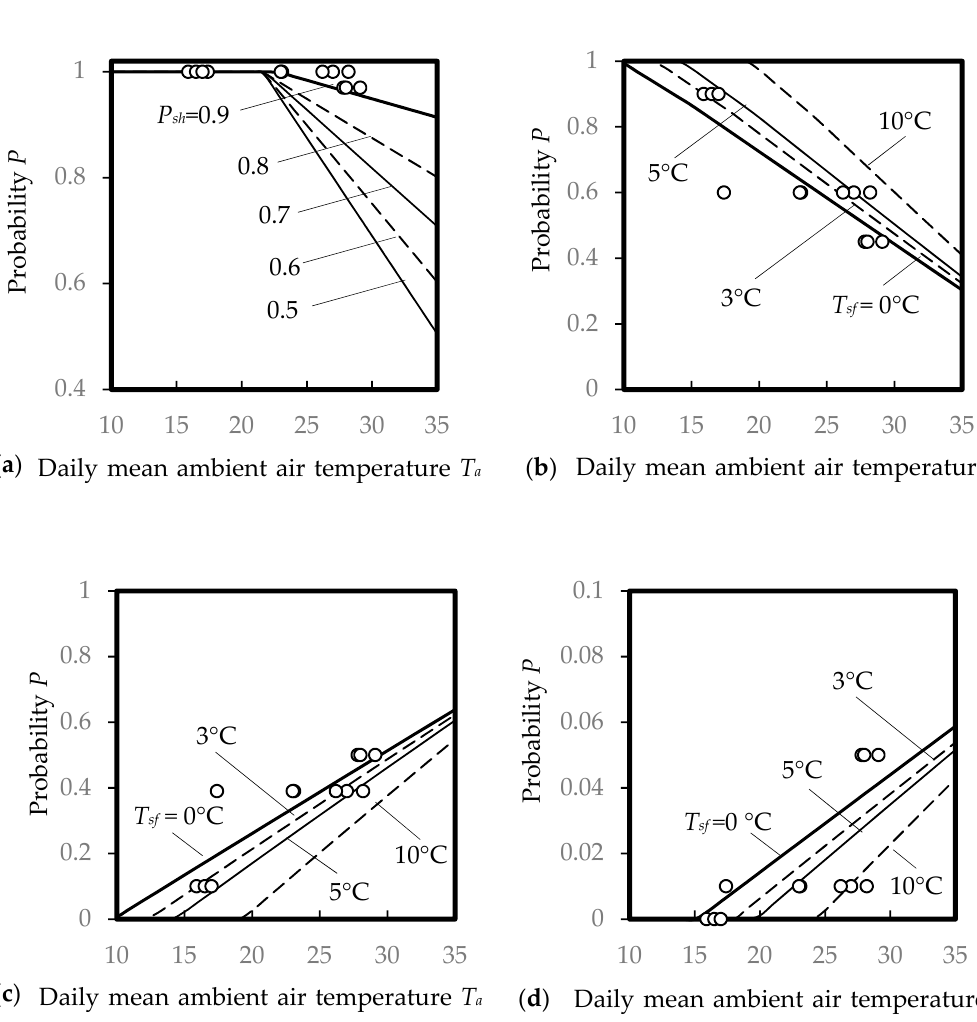
Figure 1. Probability of daily per capita shower usage: ( a ) Hot water used P sh ; ( b ) Once per day P s 1 ; ( c ) Twice per day P s 2 ; ( d ) Thrice per day P s 3 . Table 1. Constants for per capita showering characteristics.